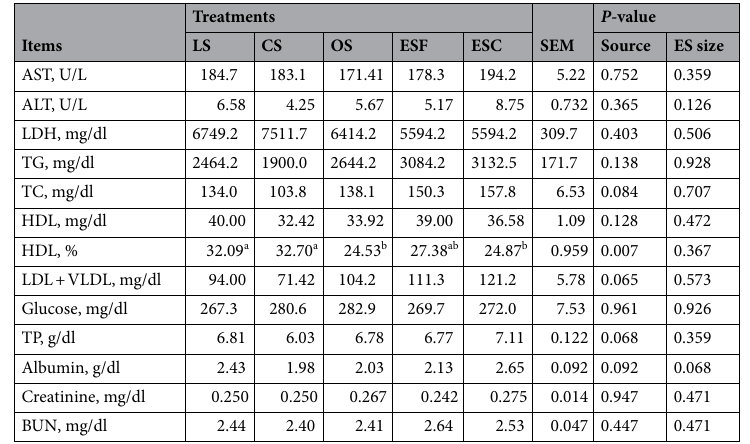
Table 3. Blood biochemical constituents of laying hens at 80 week of age according to the treatments. Results are the means of 12 hens at 80 week of age. LS limestone (< 2 and 2–4 mm mixed in 3:7); CS cockle shell (1–4 mm); OS oyster shell (3–16 mm); ESF eggshell fine particles (< 1 mm); ESC eggshell coarse particles (3–5 mm). SEM standard error of means, ES eggshell, AST aspartate aminotransferase, ALT alanine aminotransferase, LDH lactate dehydrogenase, TG triglycerides, TC total cholesterol, HDL high density lipoprotein, LDL low density lipoprotein, VLDL very low density lipoprotein, TP total protein, BUN blood urea nitrogen (BUN). a,b Means with the different superscript in the same row differ significantly ( P <